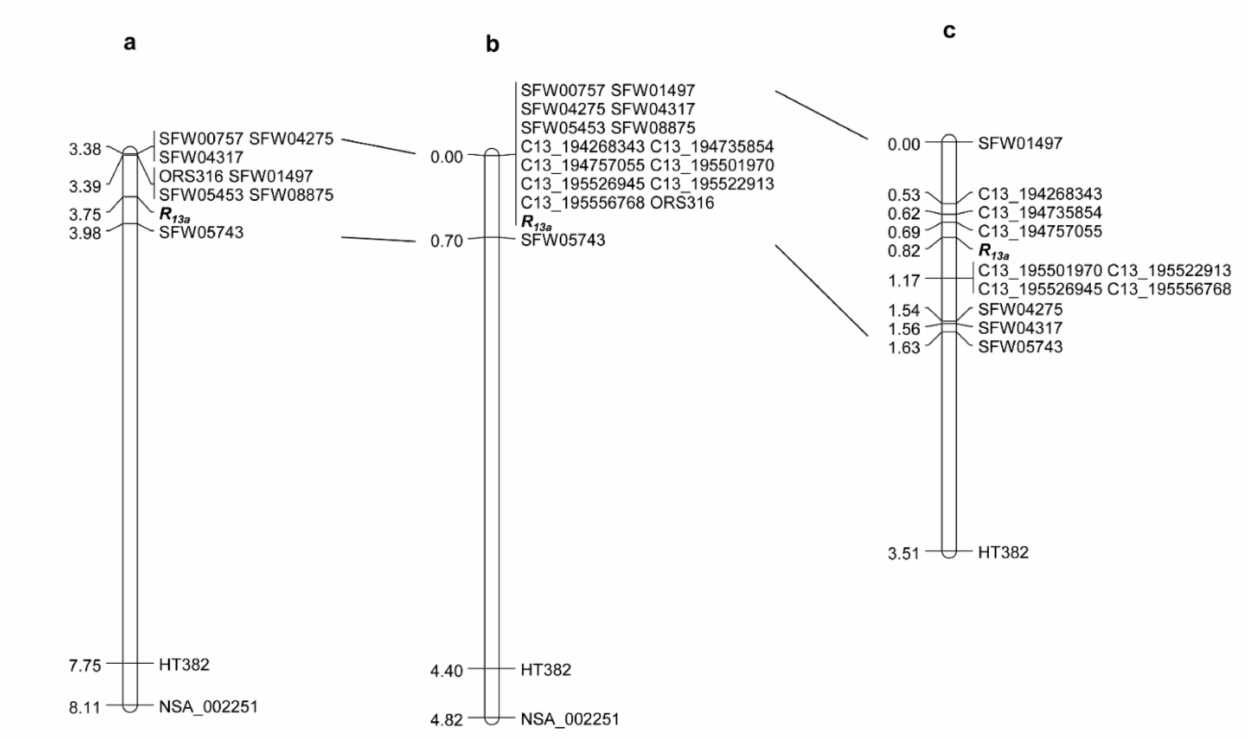
Figure 1. Rust R 13a gene linkage maps. ( a ) Map taken from Qi et al., 2015 [75], ( b ) R 13a saturation map, and ( c ) R 13a fine